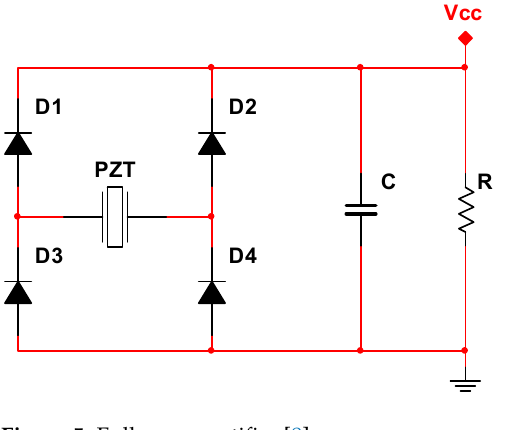
Figure 5. Full-wave rectifier [8].